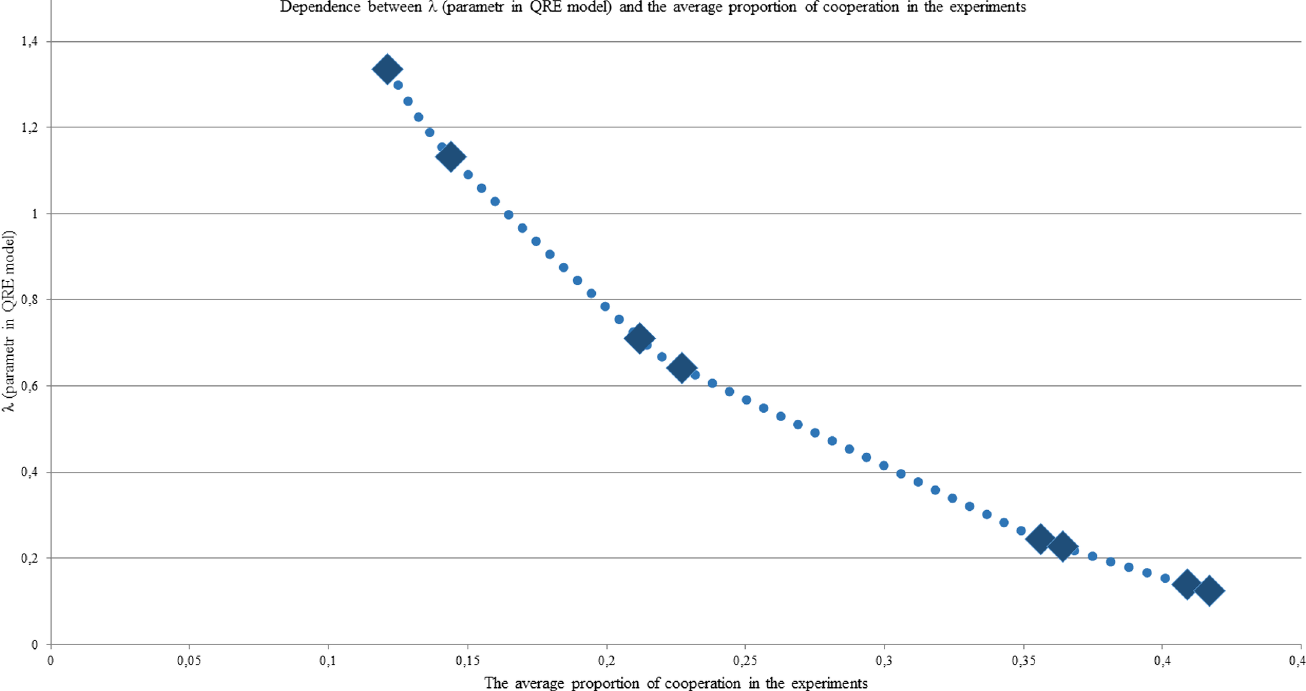
Fig 3. The averagelevel of cooperation and the QRE parameter for all experiments in PD before the Socialization stage. The λ parameter (y-axis) as a function of the averagelevel of cooperation in every experiments